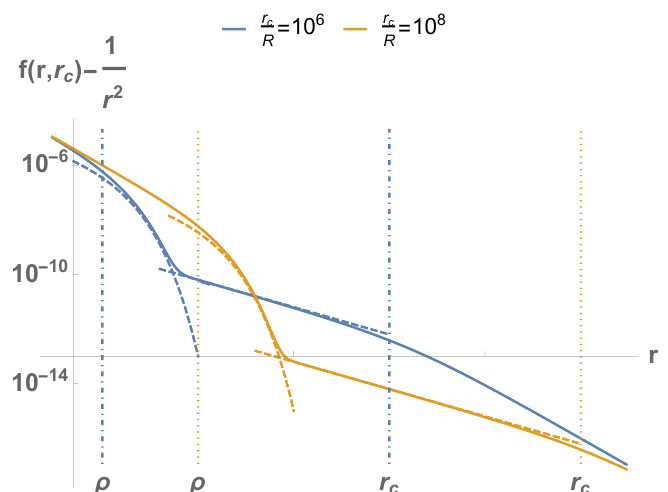
as a function of r (in units of r 2 (cid:0)p p 2 r p 2 e p rc , for r ! (cid:26) , r r c (cid:0)p p 2 r 2 e (cid:26) r(cid:26)